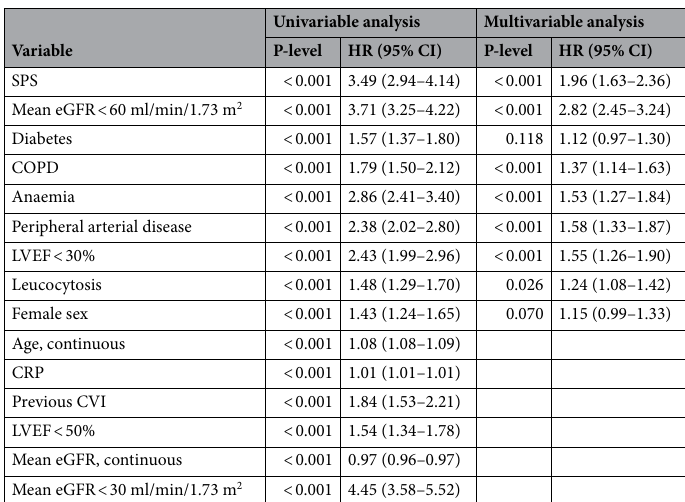
Table 2. Cox univariable and multivariable analysis of risk factors for mortality. COPD chronic obstructive pulmonary disease, CVI cerebrovascular insult, eGFR estimated glomerular filtration rate, LVEF left ventricular ejection fraction, SPS shrunken pore syndrome.